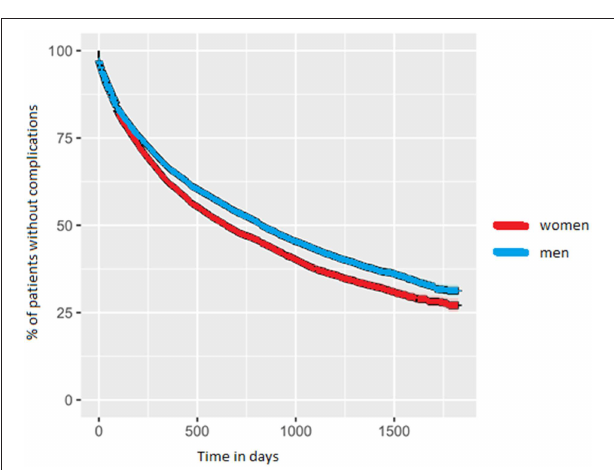
FIGURE 2 | Kaplan-Meyer curve of the time-to-event analysis for PD-related complications.